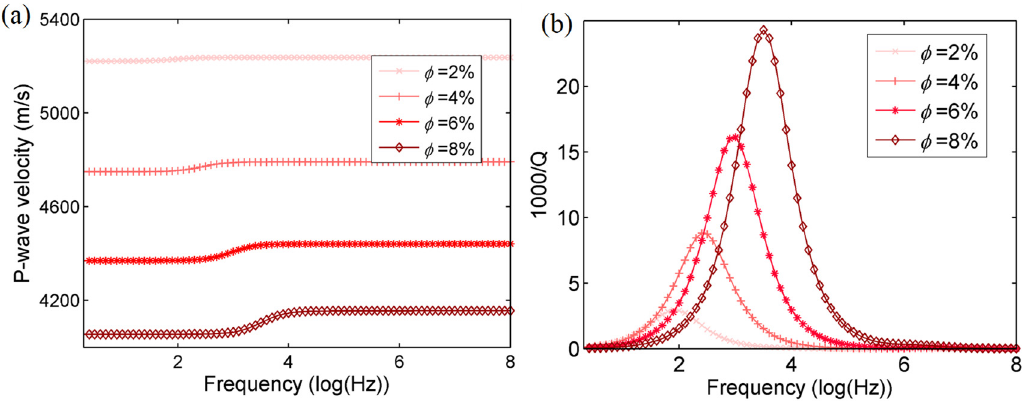
Figure 6. P-wave velocity ( a ) and dissipation factor ( b ) as a function of frequency and different total porosities. Figure 7 shows the P- and S-wave velocities as a function of the total porosity for various microcrack porosities at 1 MHz. As can be seen, the velocities decrease with increasing total and microcrack porosities, as expected.